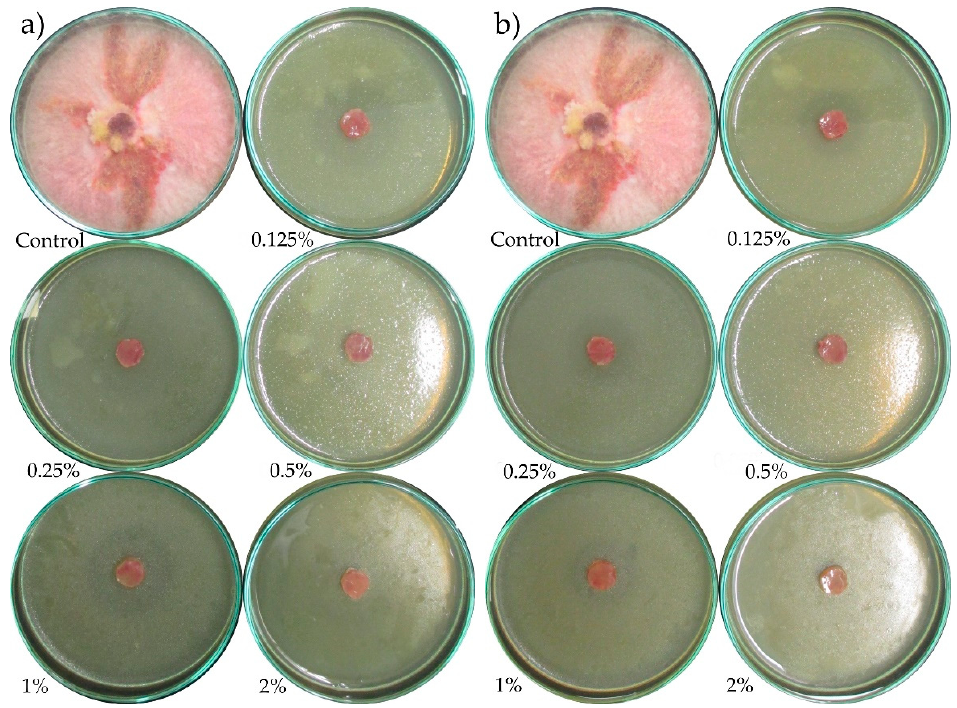
Figure A5. The effect of geranium oil concentrations on the growth of Fusarium graminearum ZALF 24 ( a ) and Fusarium graminearum ZALF 339 ( b ).